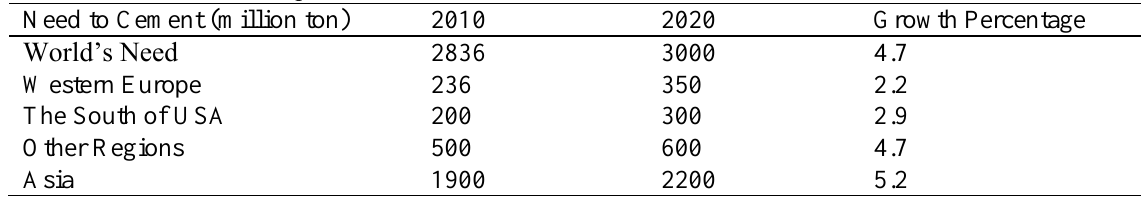
Table 1 . The World’s Required amount of Cement in Future Need to Cement (million